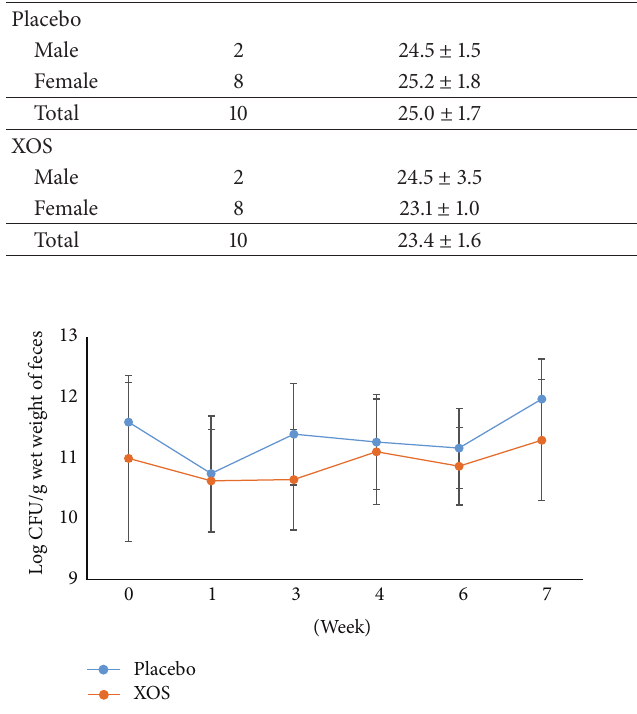
Figure 2: The changes in logarithm number (mean ± SD) of total anaerobic bacteria during the trial. Weeks 0-1: a run-in phase. Weeks 6-7: a 1-week washout phase.